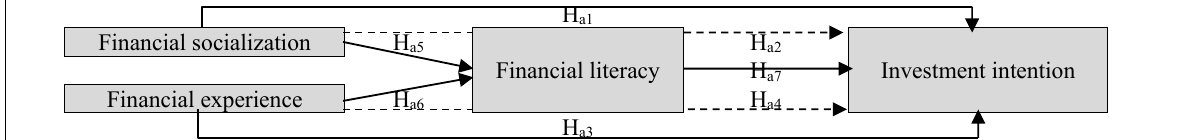
Fig. 1. Conceptual framework of the